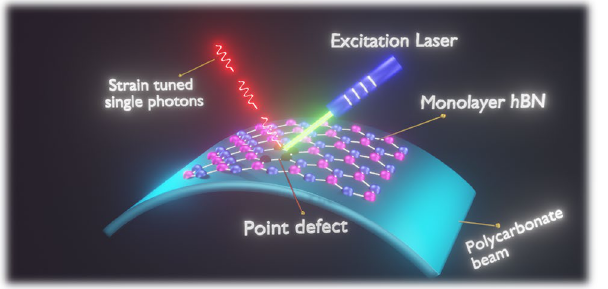
Figure 1. Schematic illustration of quantum emission tuning towards near-IR region by external strain inducement. The luminescent point defect in hBN as formed by various defect fabrication processes, was subjected to external strain using bendable polycarbonate beam, under optical laser excitation to tune the quantum emission wavelength to the telecom wavelength range in order to meet the quantum communication